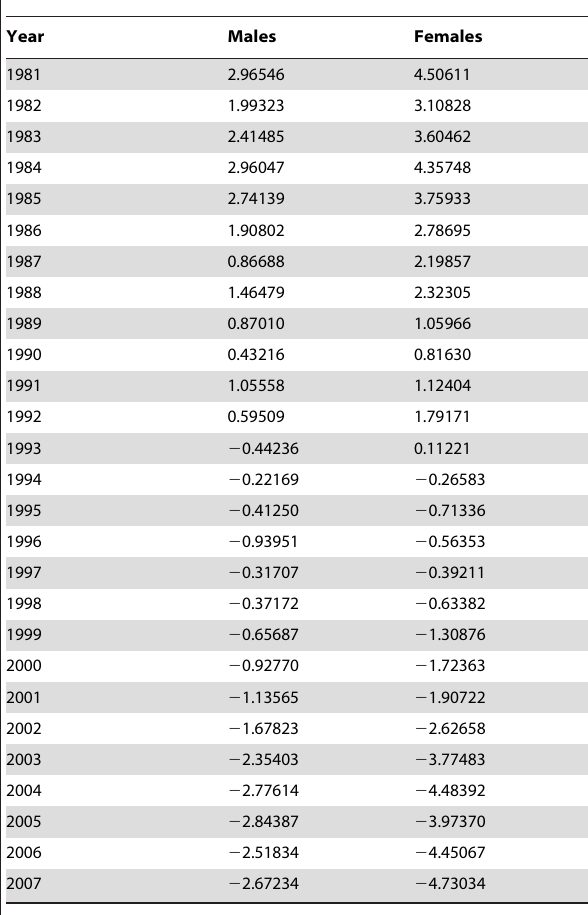
Table 2. Estimated k t values during 1981–2007 for